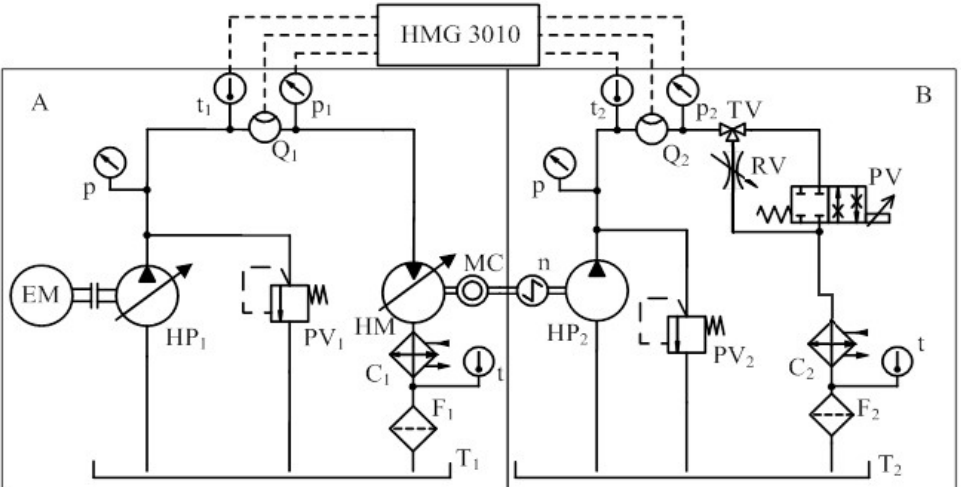
Figure 1. Laboratory equipment for measuring the parameters of hydrostatic transducers. Legend: